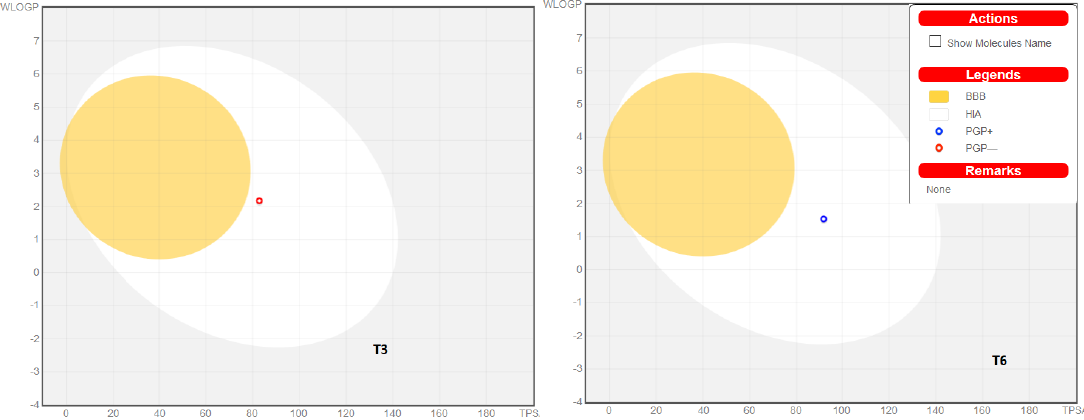
Figure 7. The BOILED-Egg construction of T3 and T6 .